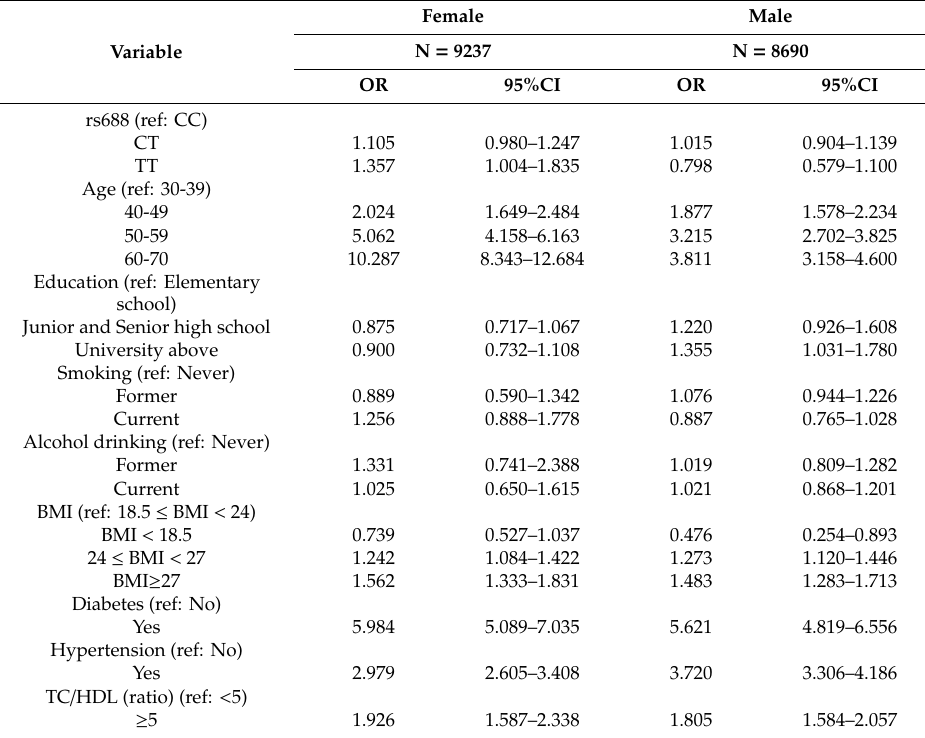
Table 4. Odds ratio for hyperlipidemia based on gender.